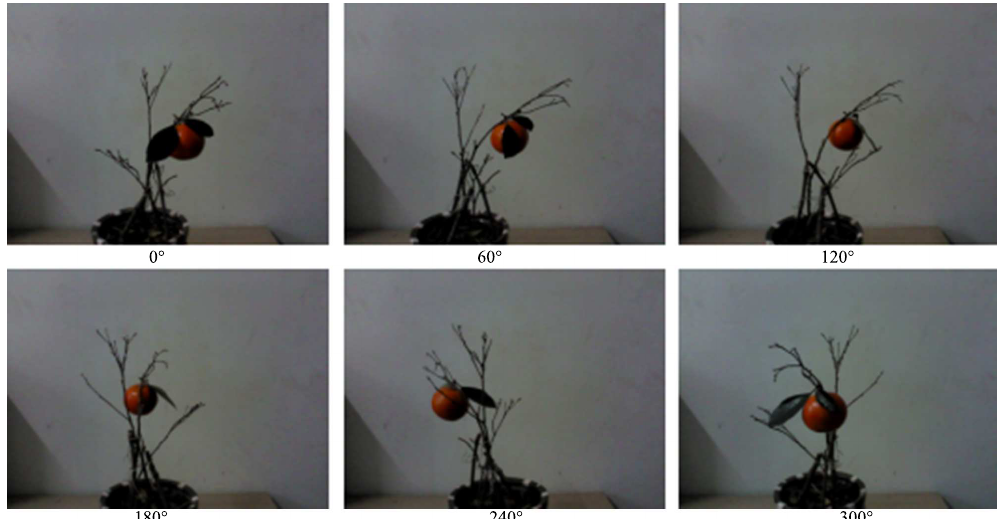
Figure 13. A set of citrus experiment position-postures.